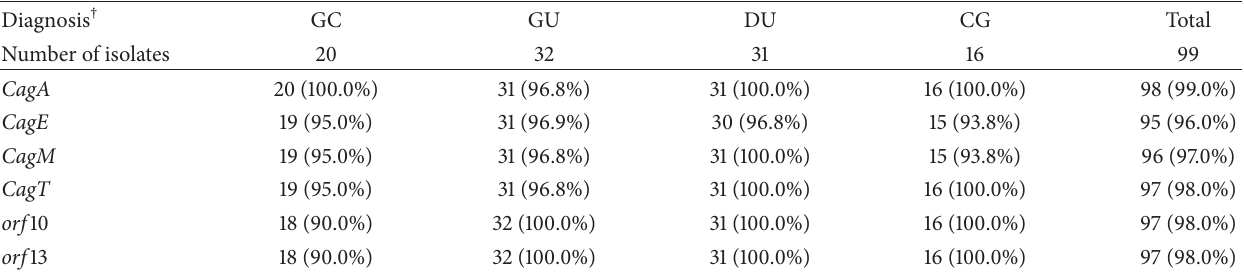
Table 2: Prevalence of H. pylori virulence factors among isolates from patients with gastric carcinoma, gastric ulcer, duodenal ulcer, and chronic gastritis.